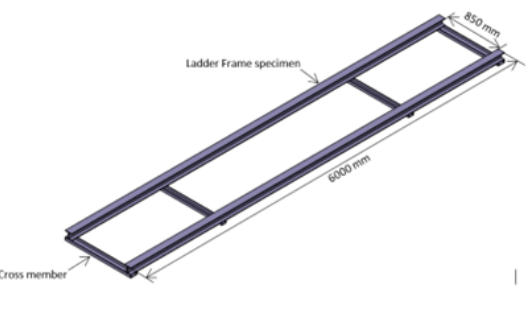
Fig. 2. Ladder frame specimen